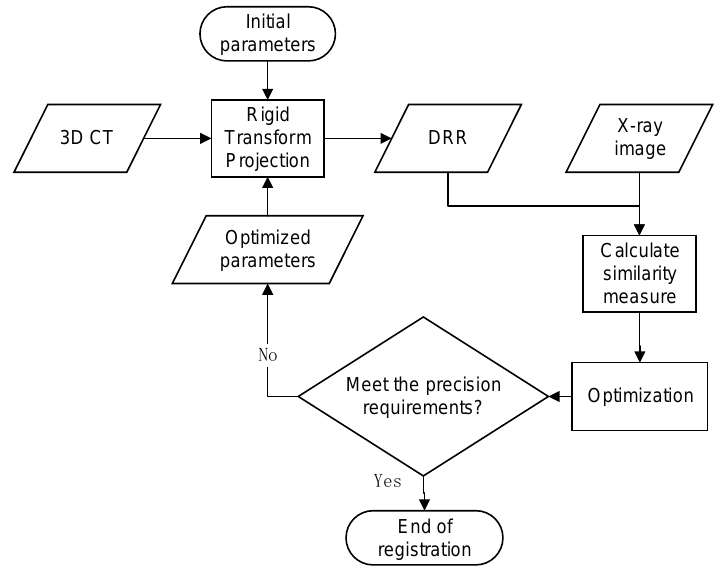
Figure 3. Image registration flow chart.